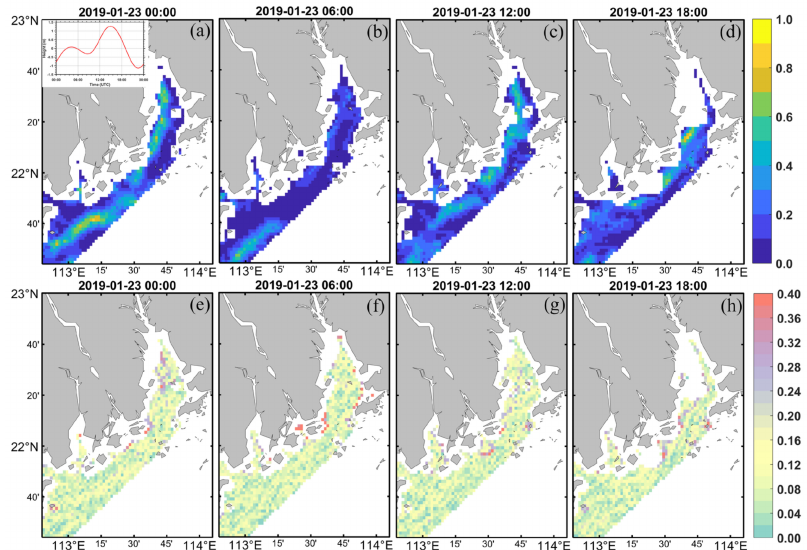
Figure 5. Spatial patterns of 10-minutely frontal intensity represented by both Jensen–Shannon divergence (JSD) ( a – d ) and gradient magnitude (GM) ( e – h ) on 23 January 2019. Corresponding tidal height is shown in upper-left corner of ( a ). The subtitles in subplots ( a – h ) indicate the corresponding observation time (unit: UTC).